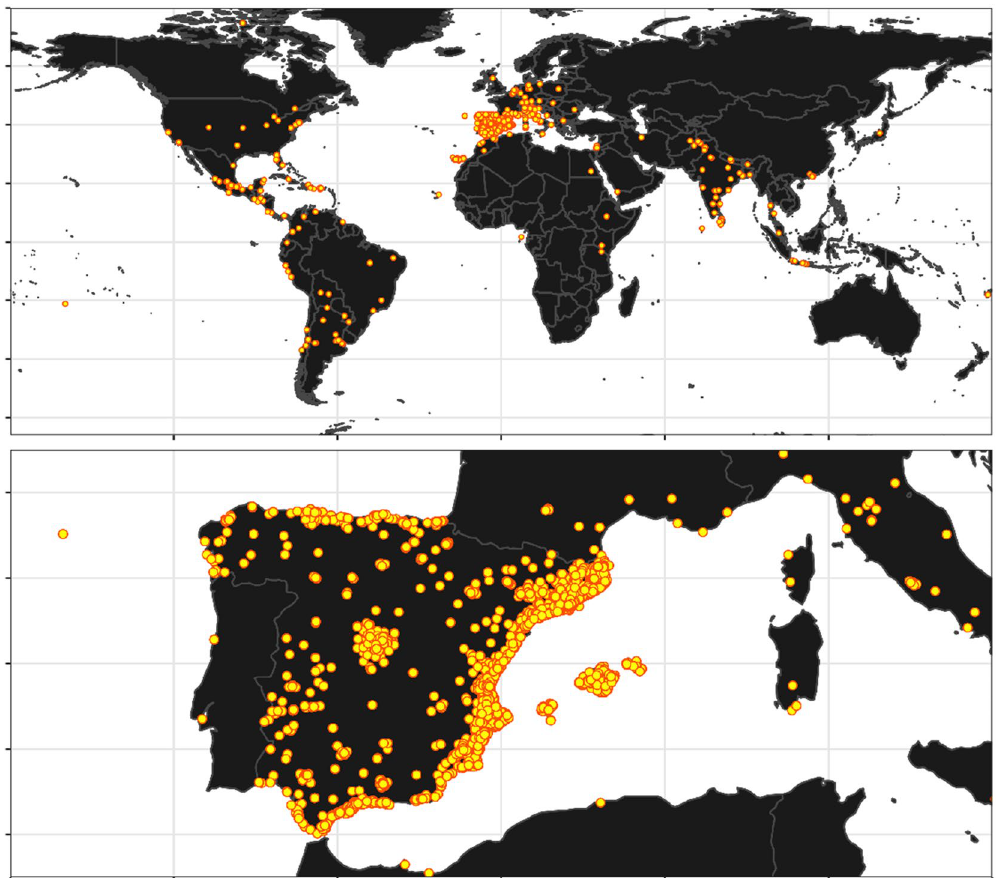
Figure 1. Geographical diversity of the submitted images based on the provided geolocation tags. It can be clearly seen that while the vast majority of the Mosquito Alert participants are based in Europe (particularly Spain), images were taken all over the world. The map was made with Natural Earth public domain map data (https ://www.natur alear thdat a.com/) using the rnaturalearth package version 0.1.0 24 in R version 4.0.2 25 (https :// www.R-proje